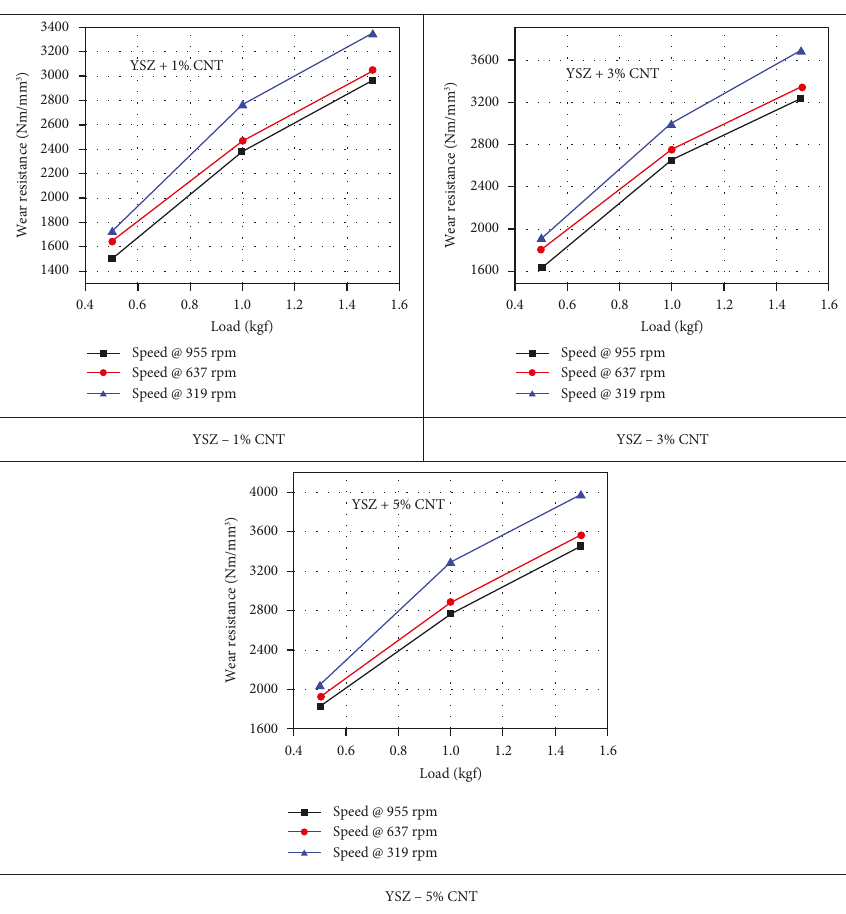
Figure 9: Calculated wear resistance for the test experiments on YSZ+CNT coatings for different rotational speed.